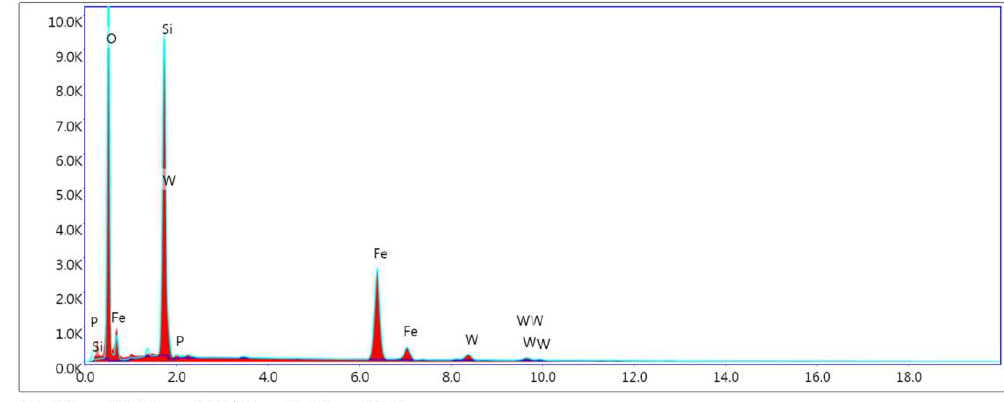
Figure 3. EDX spectrum of the Fe 3 O 4 @SiO 2 @HPW catalyst. Table 1. EDS analysis of the Fe 3 O 4 @SiO 2 @HPW catalyst.